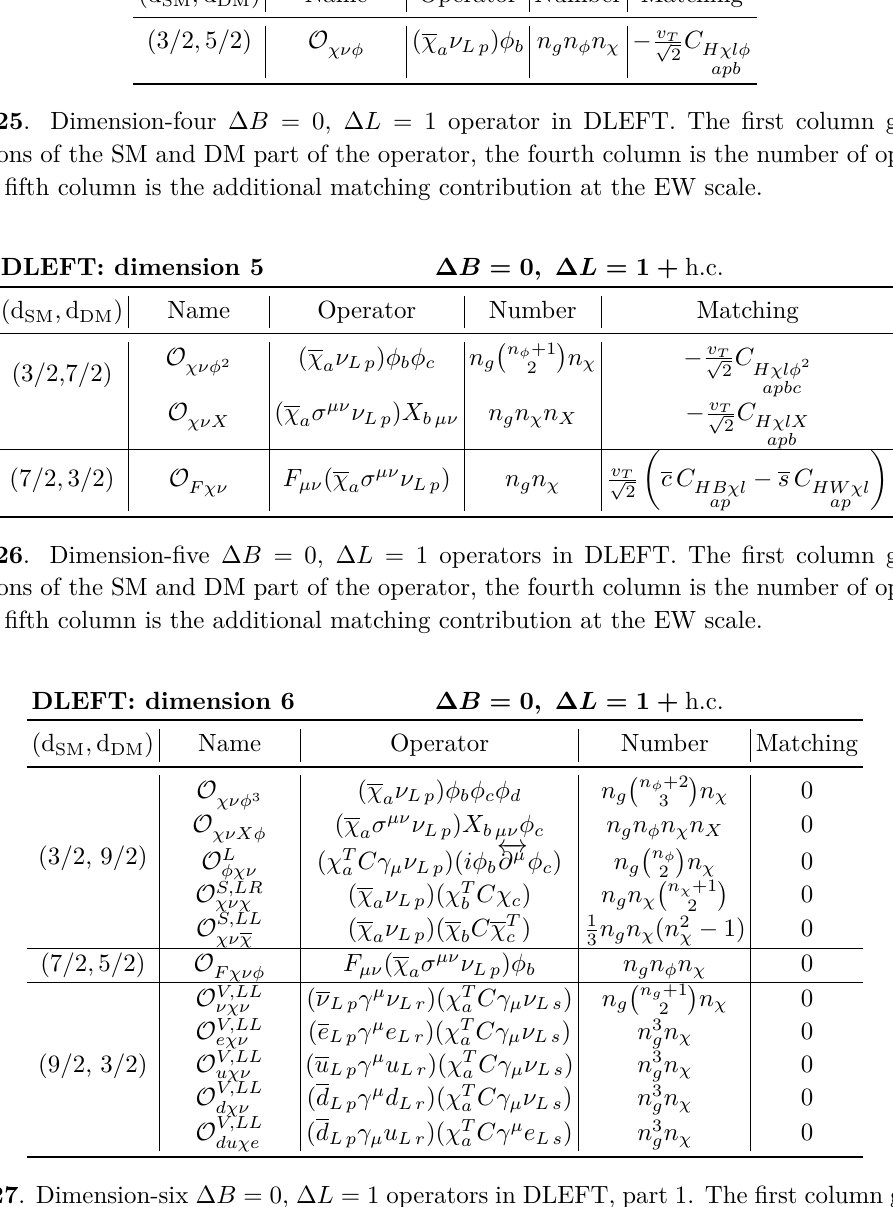
Table 27 . Dimension-six ∆ B = 0 , ∆ L = 1 operators in DLEFT, part 1. The first column gives the dimensions of the SM and DM part of the operator, the fourth column is the number of operators, and the fifth column is the additional matching contribution at the EW